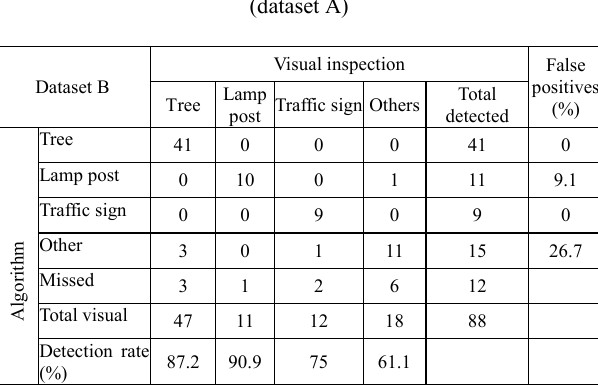
Table 3: Confusion matrix of the detected result based on object wise (dataset